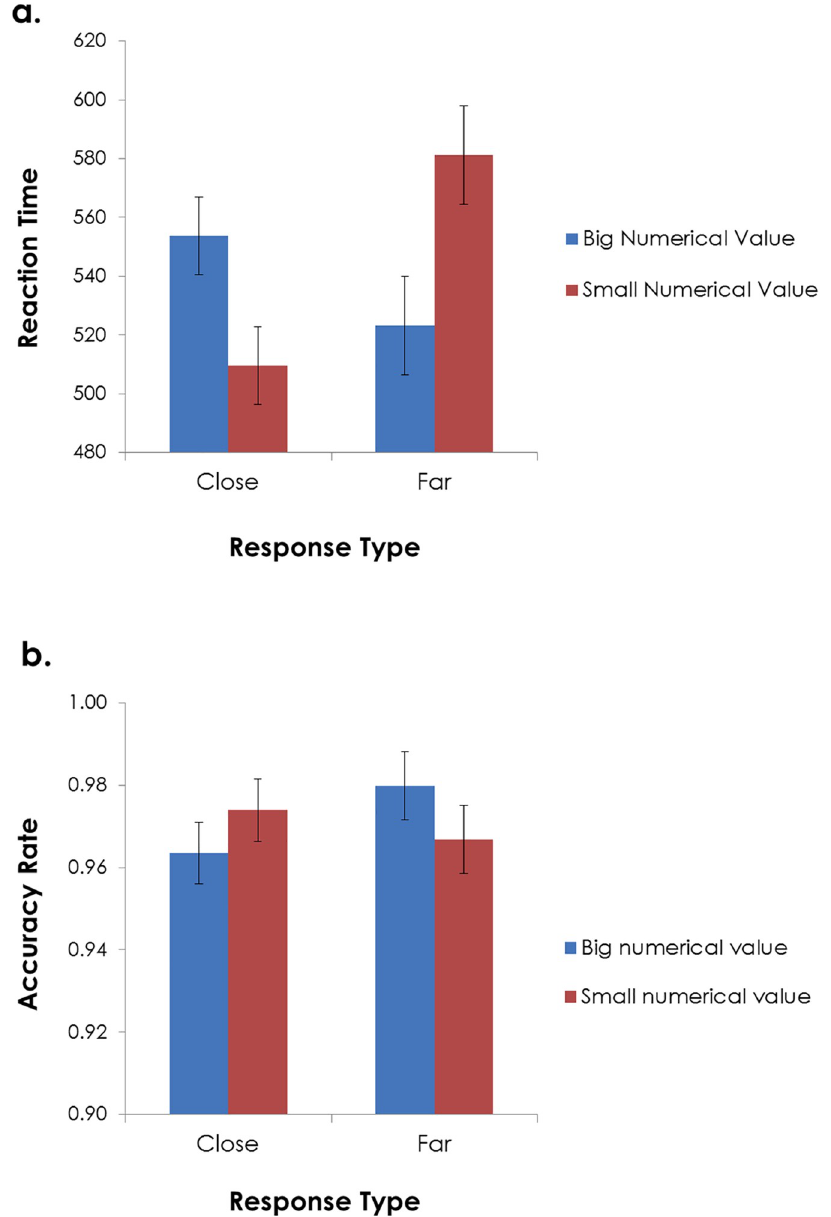
Fig 1. Reaction times (a) and accuracyrates (b) in Experiment 1 as a function of response type (i.e., key distance) and numerical value. Standard errors are computedfor the difference score (betweenbig and small numerical values) [19], within each of the responsetype